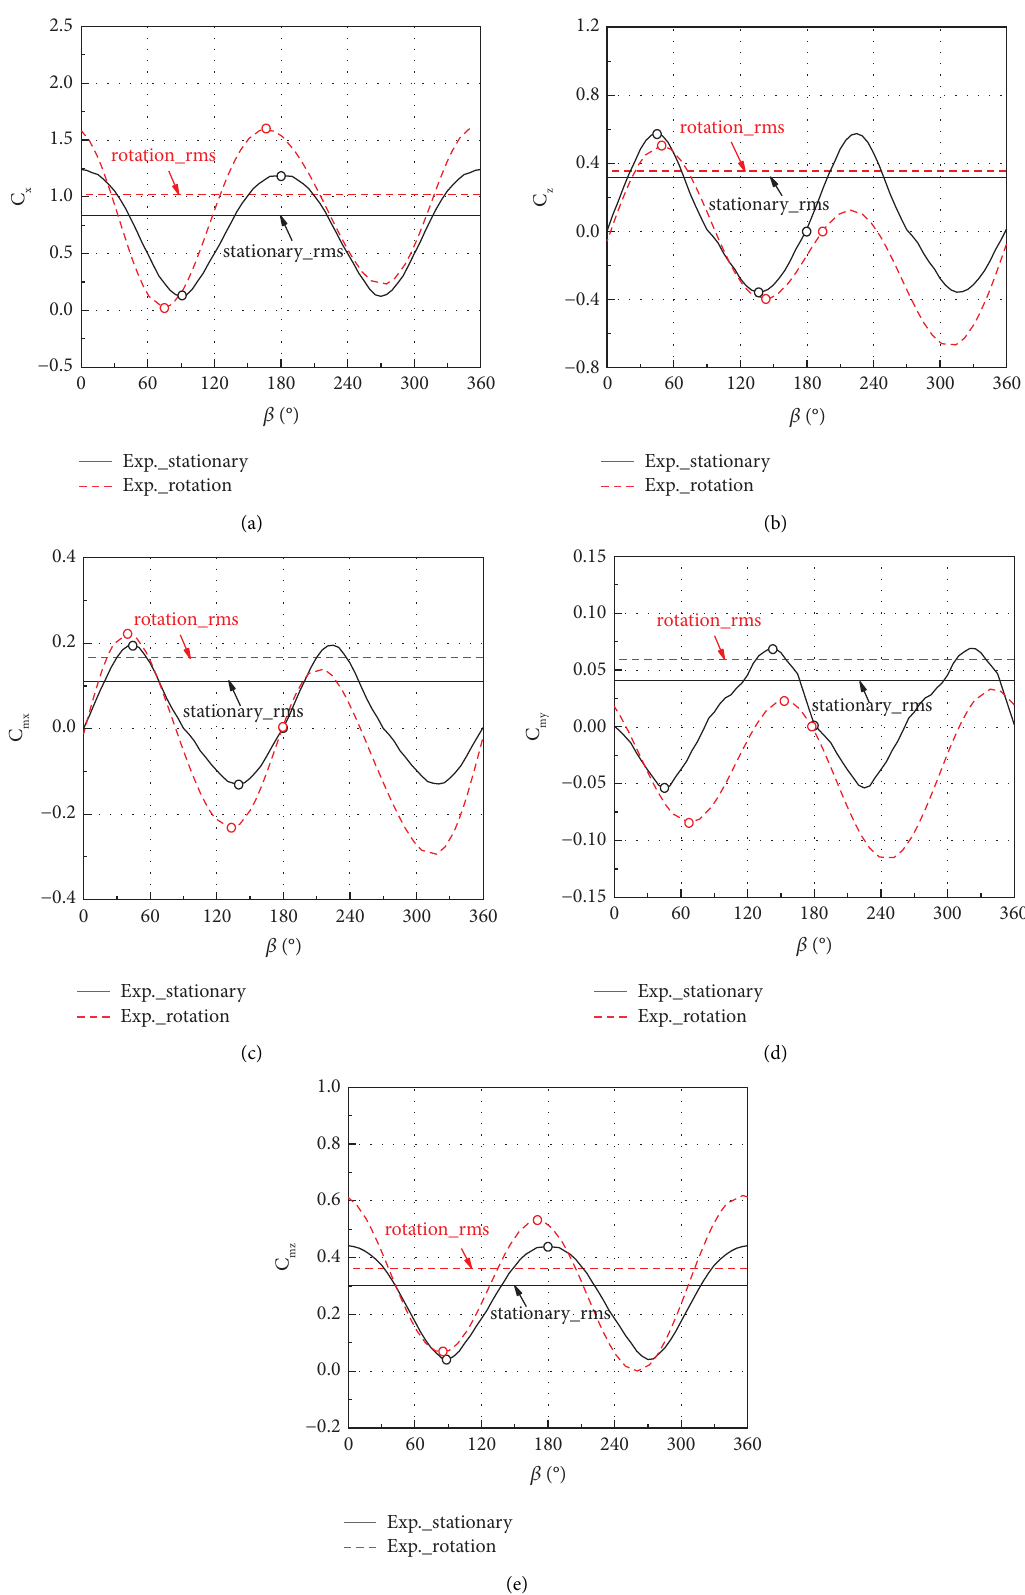
Figure 18: Wind tunnel test results and numerical simulation results of aerodynamic coefficients with respect to the azimuth angle when the antenna is stationary and azimuthal rotation (porous plate). (a) C x − β , (b) C z − β , (c) C mx − β , (d) C my − β , and (e) C mz − β